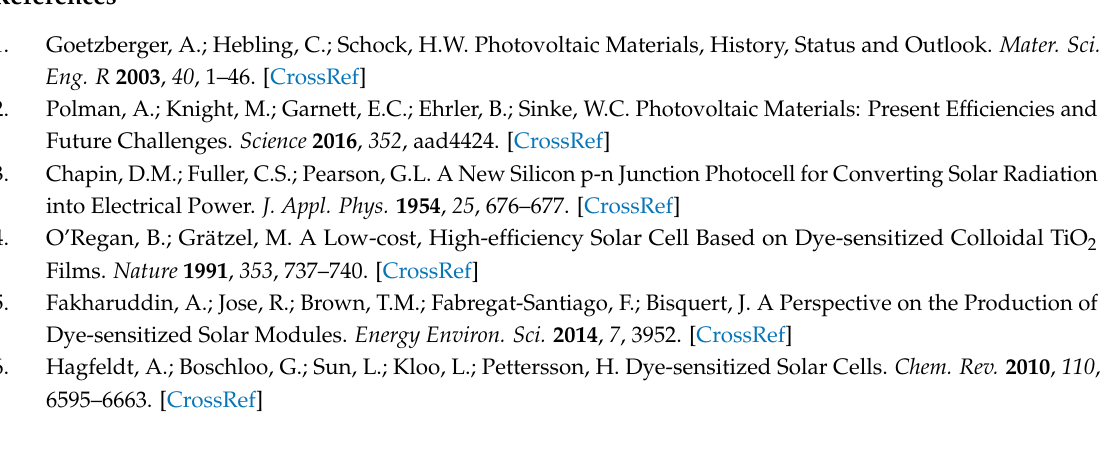
Figure S2: EDS elemental mapping images of top surface of Sn-doped TiO 2 NWAs (TS2), Figure S3: (a) the tip region of Sn-doped TiO 2 NWAs (TS2). Corresponding EELS elemental mapping images for b) Sn, c) Ti, and d) O, respectively, Figure S4: Mott-Schottky plots of the pure TiO 2 NWAs (TS0) and Sn-doped TiO 2 NWAs (TS1, TS2, TS3, TS4), Figure S5: The pH-dependent zeta-potential of the pure TiO 2 NWAs (TS0) and Sn-doped TiO 2 NWAs (TS1, TS2, TS3, TS4)., Figure S6: (a) The UV-vis diffusive reflectance spectra of the pure TiO 2 NWAs (TS0) and Sn-doped TiO 2 NWAs (TS1, TS2, TS3), (b) normalized UV-vis diffusive reflectance spectra and (c) the plots of transforming the Kubelka–Munk function versus the energy of light, Figure S7: Dark current density–voltage of DSSCs based on the pure TiO 2 NWAs (TS0) and Sn-doped TiO 2 NWAs (TS1, TS2, TS3, TS4); Figure S8: The enlarged low-frequency arc and full scale (inset graph) Nyquist plots of the DSSCs based on the pure TiO 2 NWAs (TS0) and Sn-doped TiO 2 NWAs (TS1, TS2, TS3, TS4) measured under 750 mV bias in the dark condition; Table S1: Detailed simulative values of the charge transfer resistance from EIS